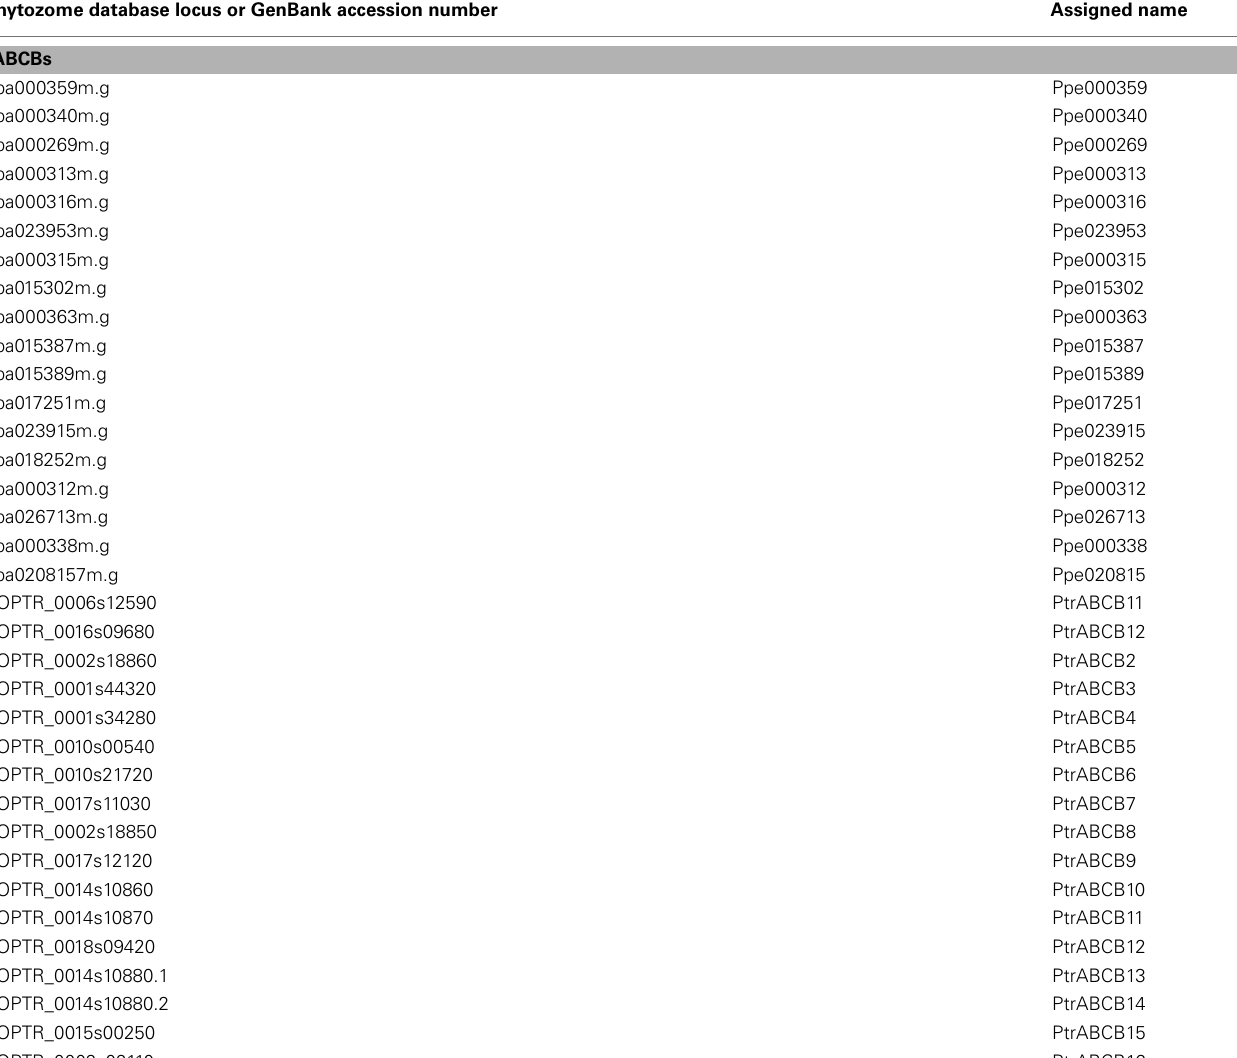
TableA4 | List of all the sequences used in the reconstruction of PIN , AUX/LAX , and ABCB families phylogenies. Phytozome database locus or GenBank accession